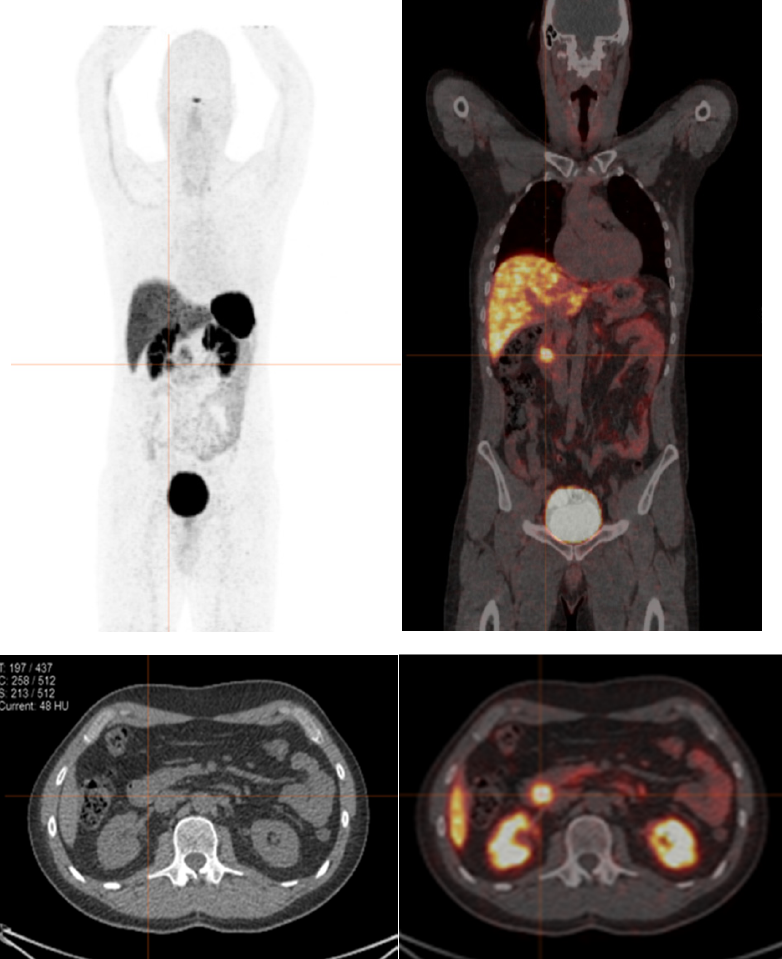
Figure 1. A 41-year-old male with recurrent NENs at the duodenum. 68Ga-DOTA-NOC PET/CT shows abnormal focal tracer uptake at the duodenum (SUVmax of 5.9), without other definite evidence of abnormal tracer uptake. Ki-67 index from endoscopic fine-needle aspiration of duodenum was 1%. It is possible that the FNA site may not fully reflect the true pathological grade of a patient with heterogeneity of cellular differentiation.